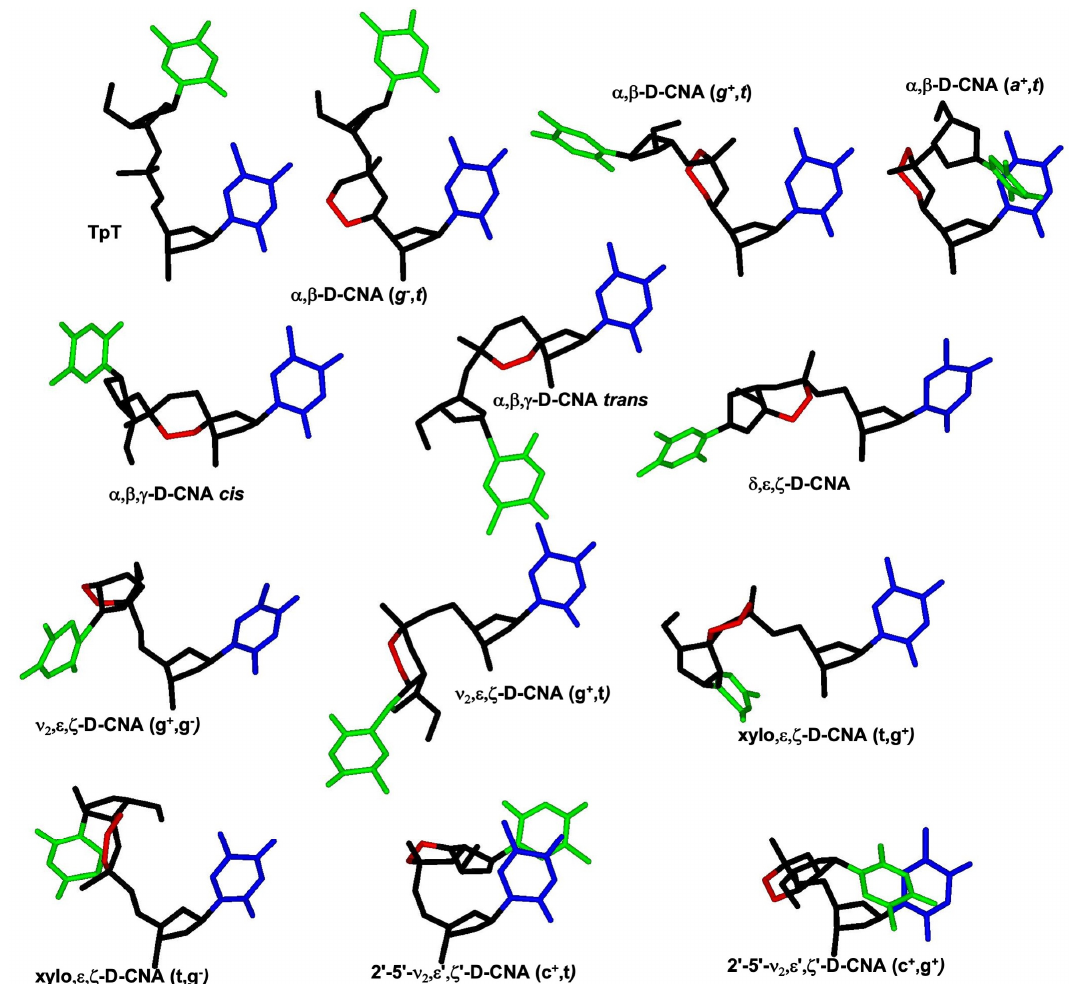
Figure 7. Representation of X-ray diffraction or NMR-based structures of selected CNAs.